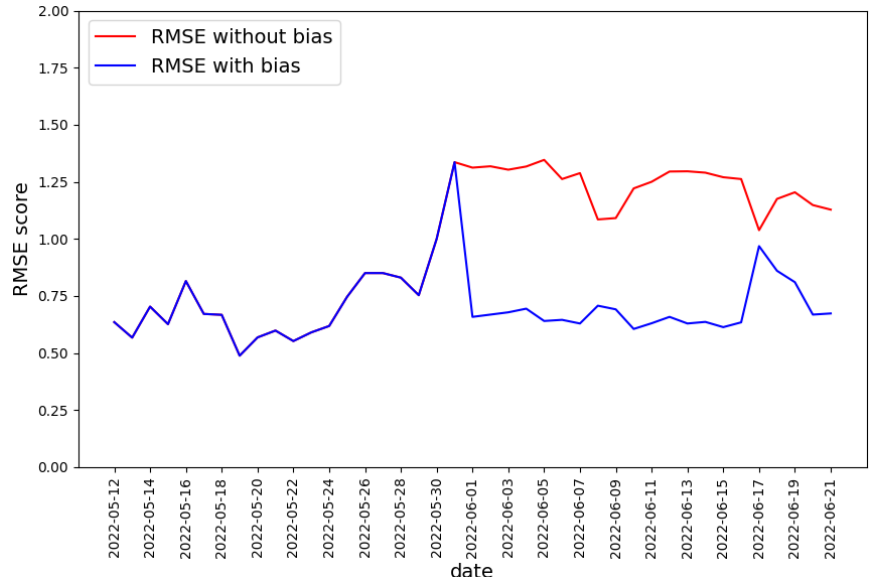
Figure 13. The RSME value obtained by the regression model in variants without and with applying bias